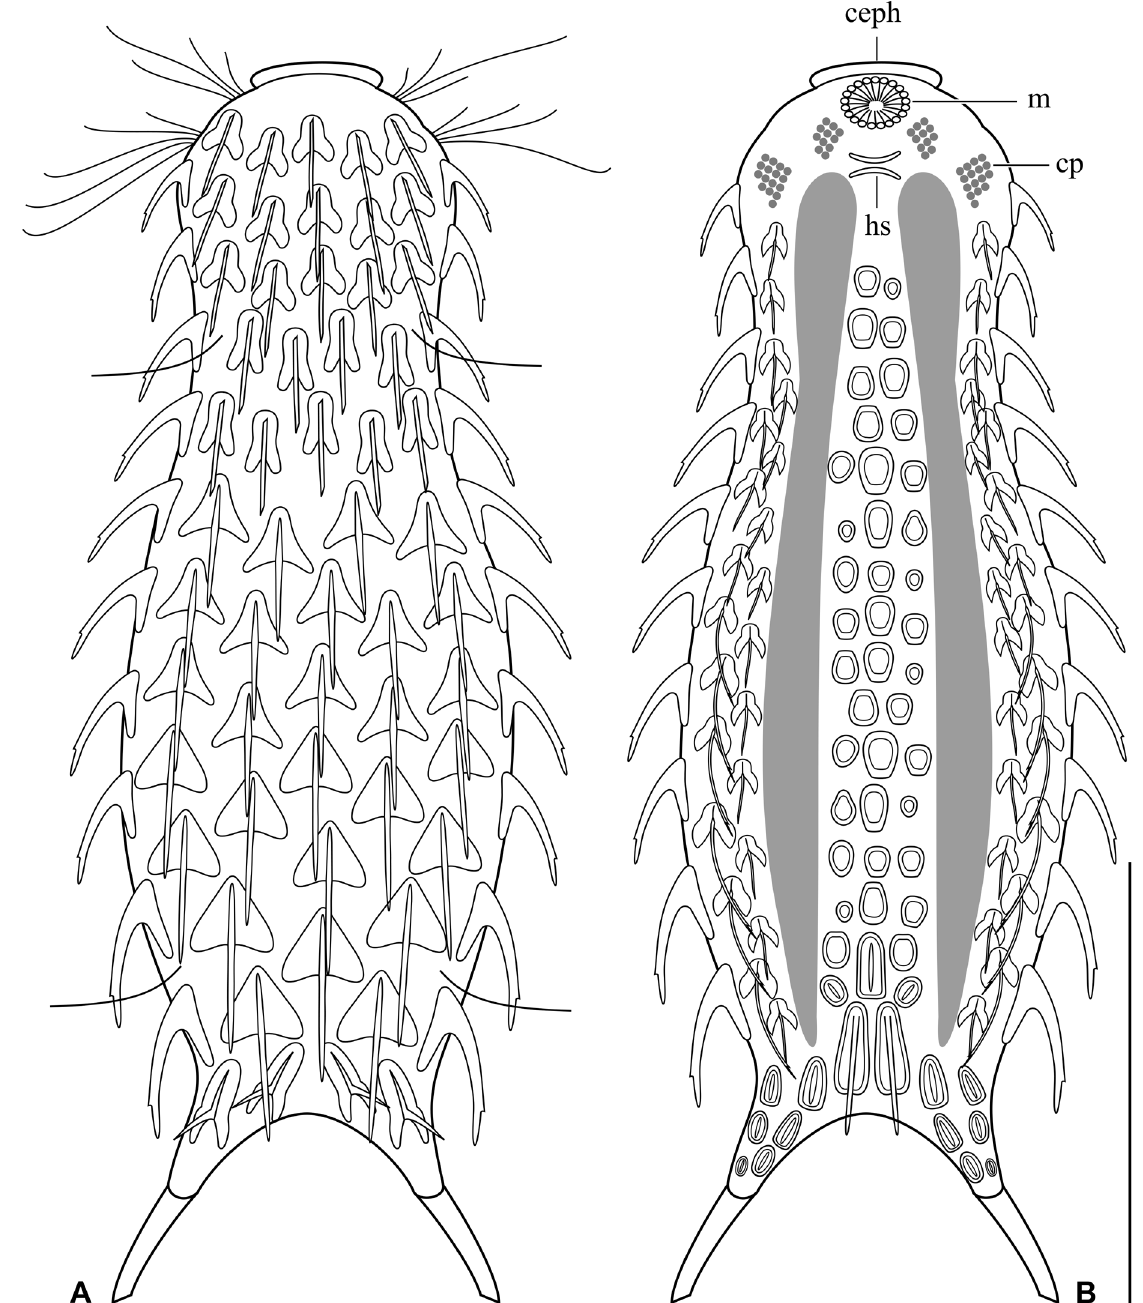
Fig. 33. Chaetonotus ( Hystricochaetonotus ) gulosus sp. nov. A . Dorsal overview showing the scale and spine pattern. B . Ventral overview showing the scale and ciliary pattern. Scale bar = 30